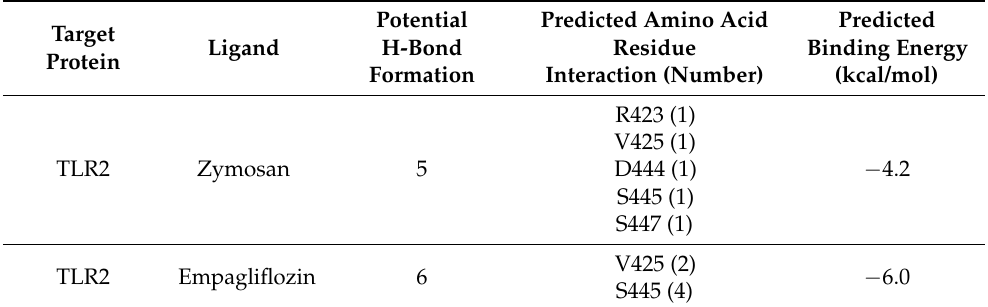
Table 1. Predicted protein–ligand interactions for TLR2-Zymosan and TLR2-Empagliflozin with binding energies from docking simulations.